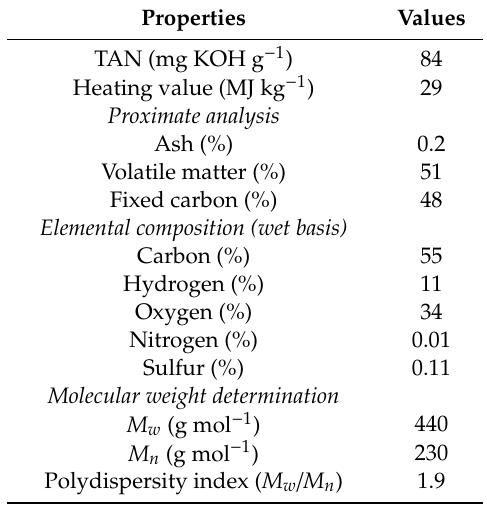
Table 4. Relevant properties of the bio-oil a from pigeon pea wood pyrolysis at optimized conditions.